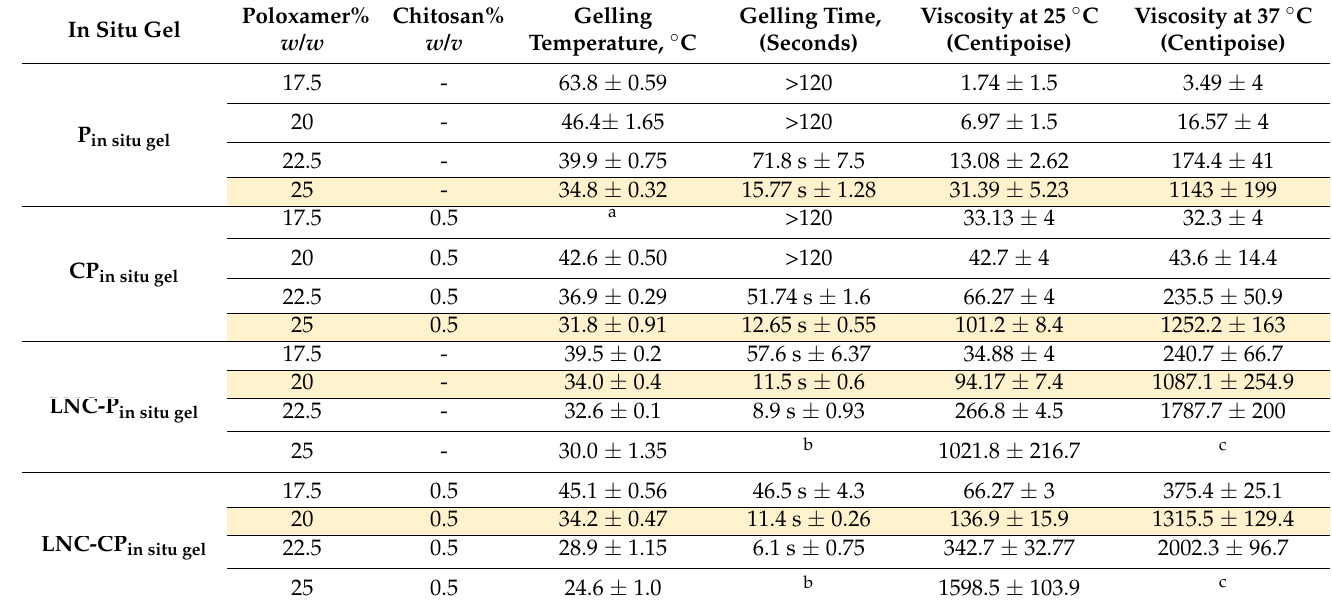
Table 1. Gelling properties and viscosity of blank P in situ gels and LNC-P in situ